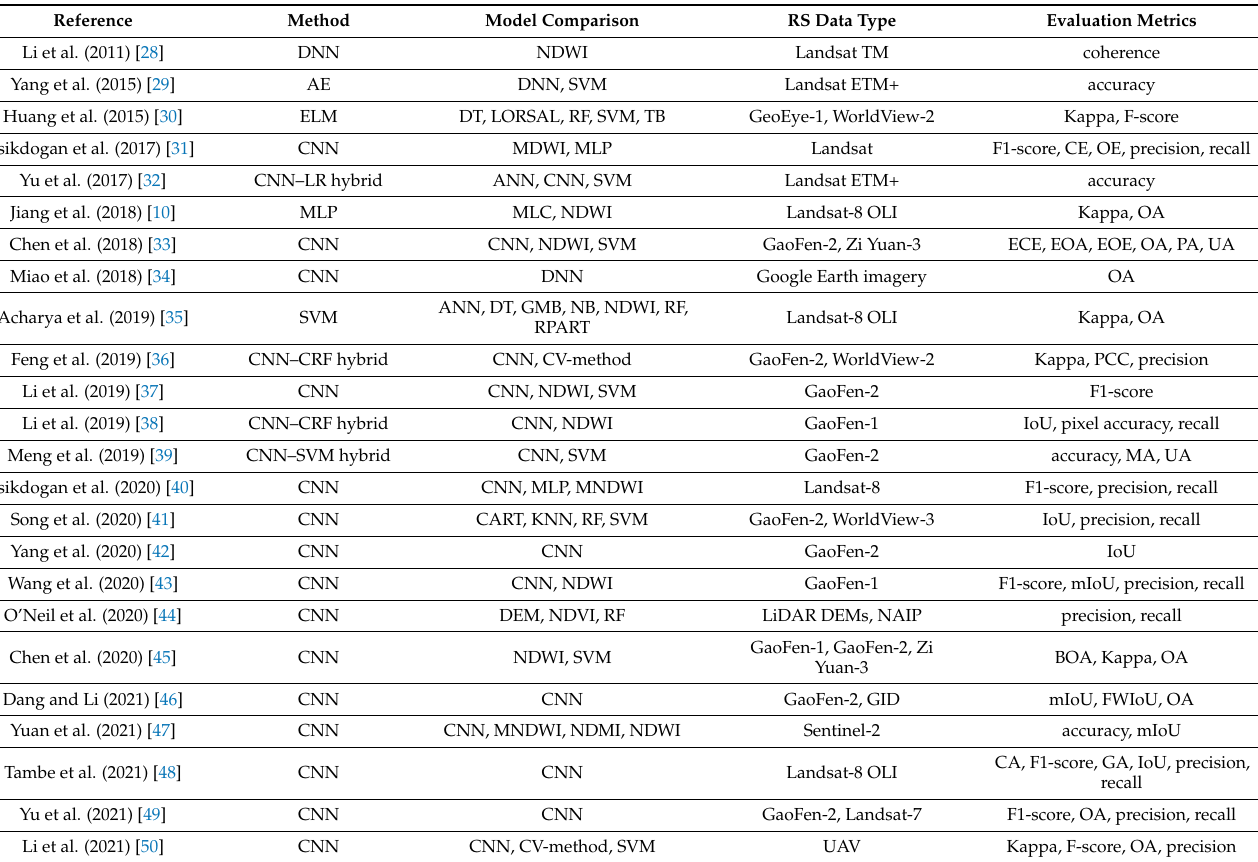
Table 2. Studies targeting water body detection from RS imagery using AI (note that it is ordered chronologically to show trends in data type and model usage; see the Abbreviations for a list of the